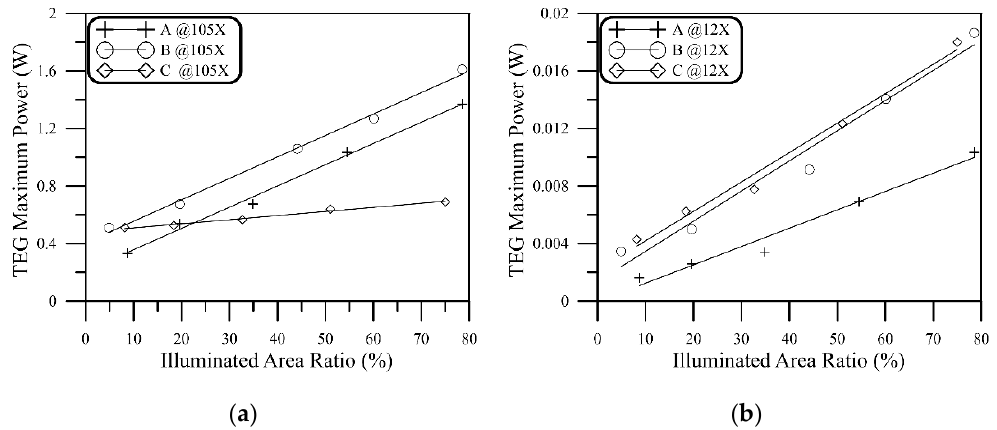
Figure 9. Maximum power of TEG samples as a function of the illuminated area percentage under light intensity of ( a ) 105 × and ( b ) 12 × .